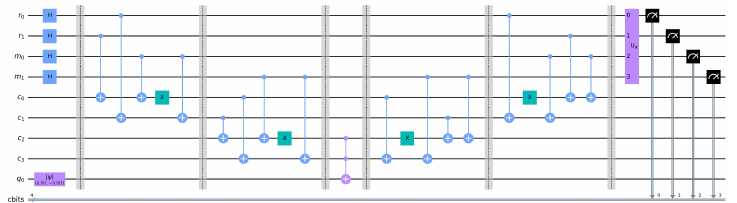
Figure 11. Implementation of the quantum circuit for the Grover procedure applied to the path plan- ning problem in the 2 × 2 environment. The search space is encoded as a the uniform superposition of the inputs through Hadamard gates, the oracle of Figure 10 covers the central part of the circuit, and the upper-right purple block is the diffuser U ψ , realized as of (12). In the rightmost part are present the measurement operation for | r (cid:105) and | m (cid:105) .